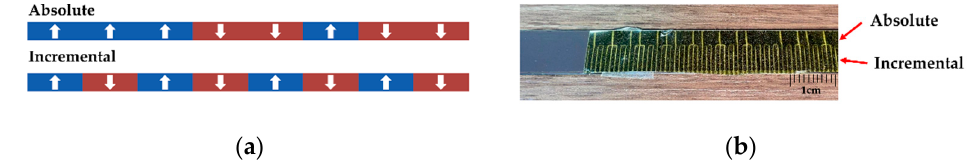
Figure 1. ( a ) The illustrations of incremental and absolute scales. ( b ) The integrated scale used in this work. The MFVF reveals the magnetic pattern on the scale.